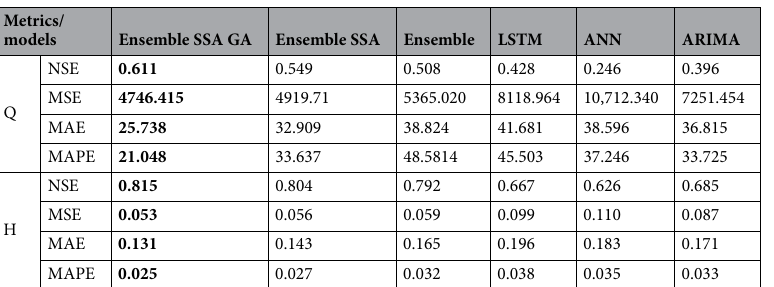
Table 10. Multi-step-ahead forecasting for Kon Tum dataset. Best results are highlighted in bold text. Our proposed method (i.e., Ensemble SSA GA) outperforms the others.